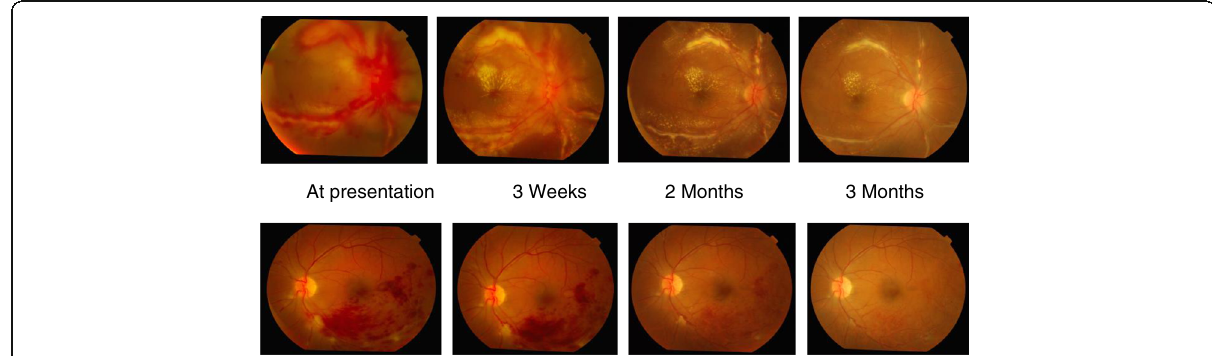
Fig. 3 3-month follow up of the patient showing resolution of the lesions. (top) Right eye and (bottom) left